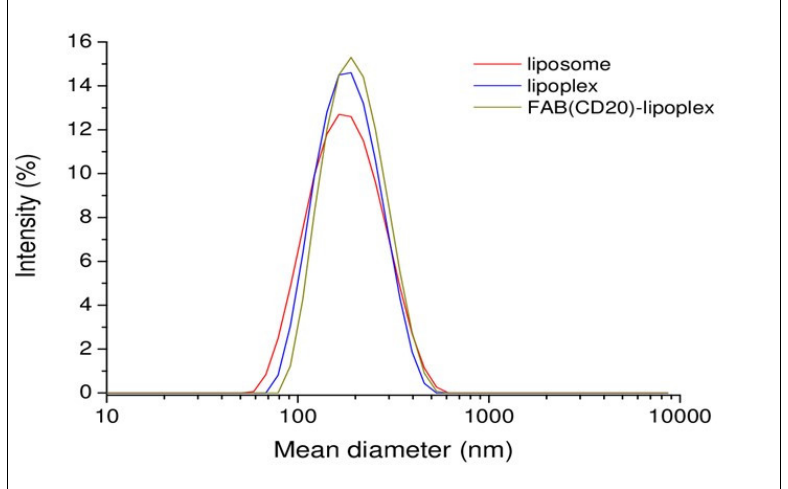
Figure 4. Intensity profiles of liposomal formulations.